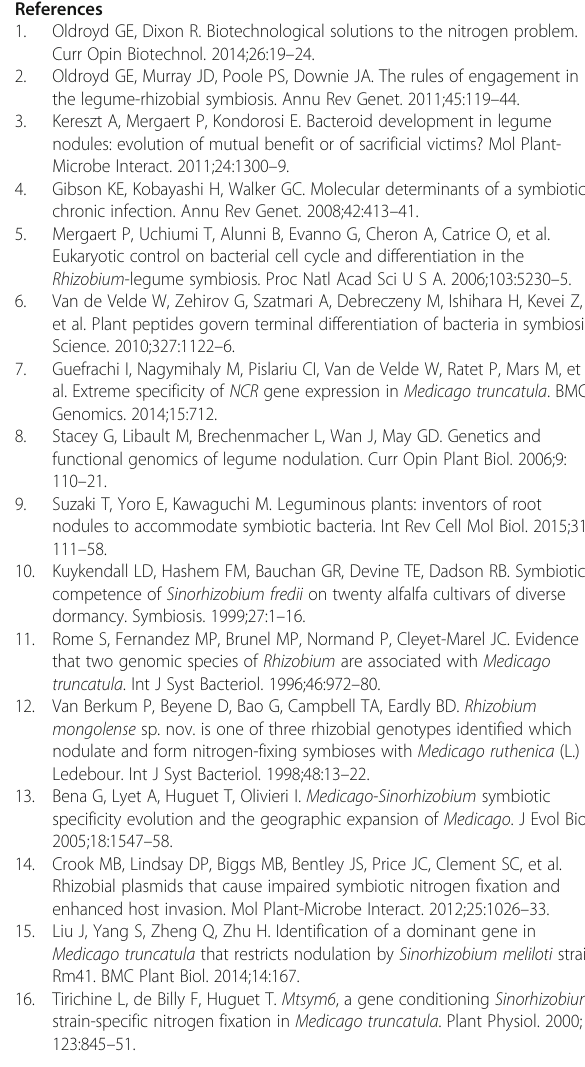
Additional file 2: Figure S2. Comparison of the organization of genes responsible for the production of the strain-specifc KPS in E. meliloti strains FSM-MA, 1021 and Rm41. The gene clusters are located between conserved genes (red arrow) coding for a 3-methyl-2-oxobutanoate-hydroxymethyl transferase (MOBHMT) and a nucleotidyl transferase. Genes determining conserved functions in KPS production such as transport (RkpR, RkpS, RkpS) or chain-length determination (RkpZ) are drawn as solid blue boxes. Open arrows with blue line indicate strain-specific rkp genes. Mustard arrows indicate genes conserved between two strains in the region. Open arrows with black line show genes with unknown function or function that could not be related to KPS synthesis. The genes are not drawn to scale. HypProt: hypothetical protein; pAcetylT: putative acetyl transferase; pMethylT: